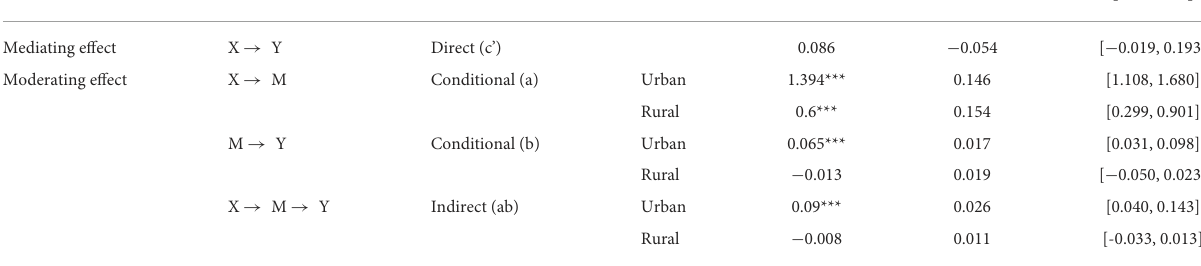
TABLE 6 Main effects of moderated mediation model.